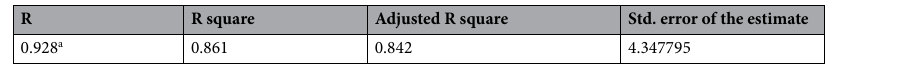
Table 3. Summary of linear regression model for predicting i corr of carbon steel in soil.